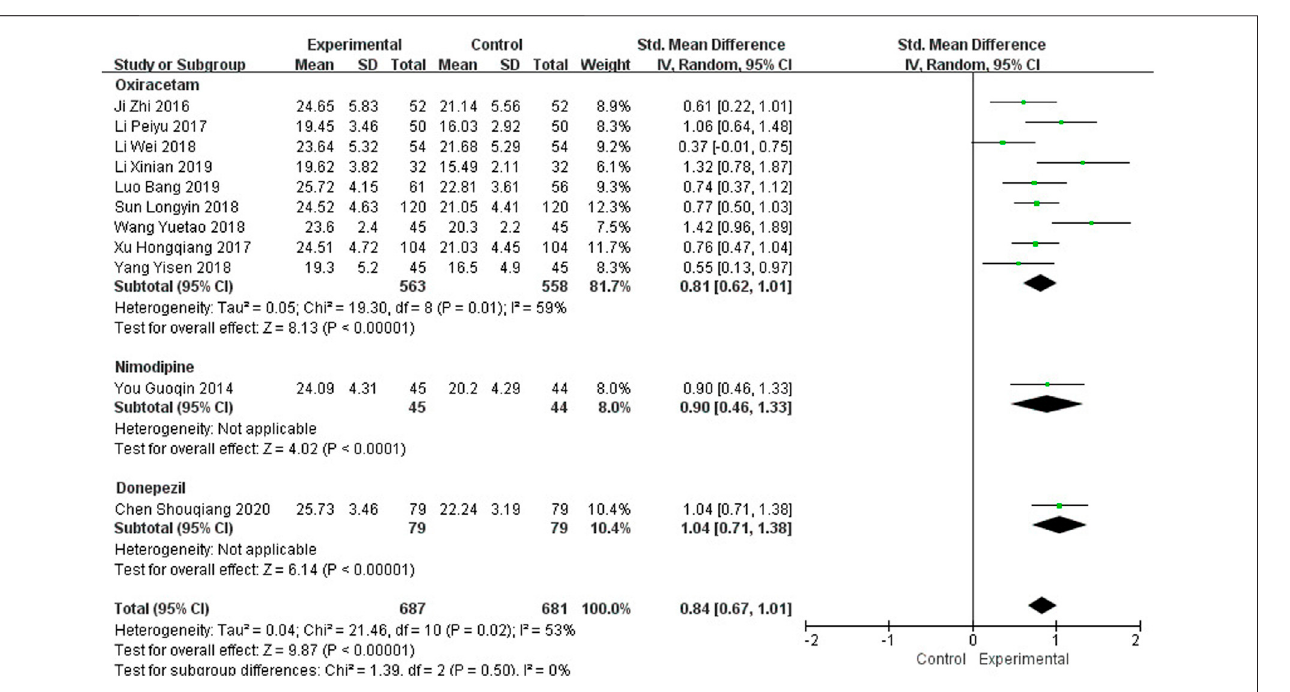
FIGURE 4 | Meta-analysis of MoCA by NBP as combination